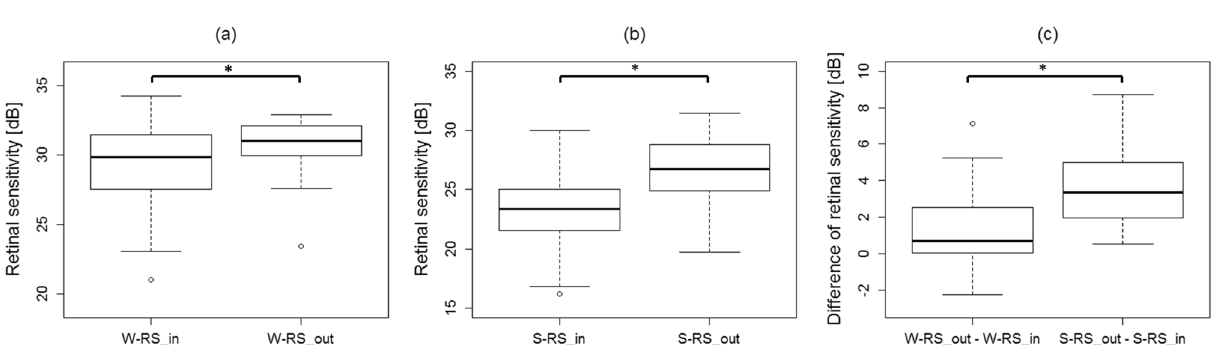
Figure 2. Correlations between retinal structure and retinal sensitivity. ( a , b ) Retinal sensitivity inside the serous retinal detachment region (W-RS_in, S-RS_in) was significantly lower than the outside (W-RS_out, S-RS_out) in both white-on-white (WW) perimetry (p = 0.006) and short wavelength automated perimetry (SWAP) (p = 0.006 and p = 2.98 × 10 −8 , exact Wilcoxon signed rank test). ( c ) The difference between the retinal sensitivity inside and outside of the SRD-affected regions was significantly larger in SWAP compared to WW (p = 5.66 × 10 −7 , exact Wilcoxon signed rank test).